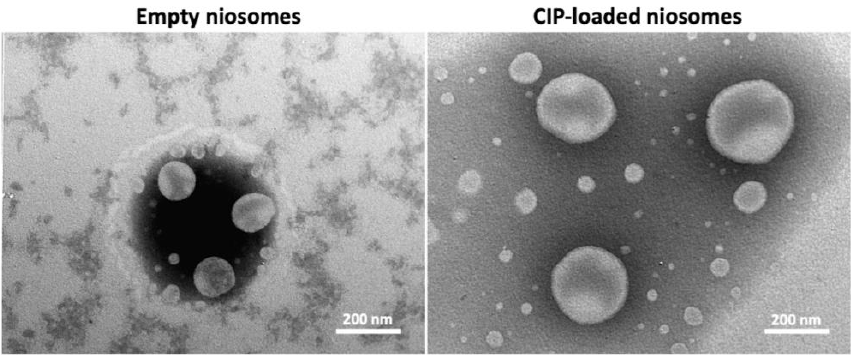
Figure 2. Transmission electron microscopy images of empty and CIP-loaded niosomes.